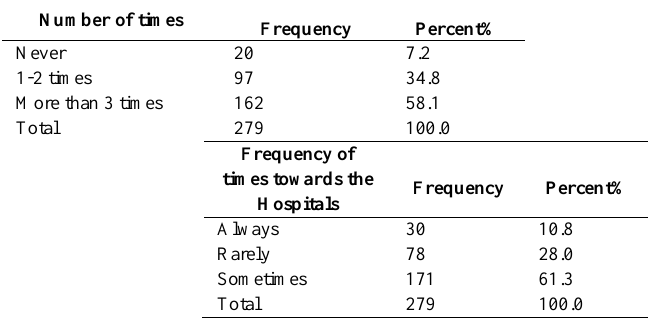
Table 4 : Frequency of times that the study population practiced self-